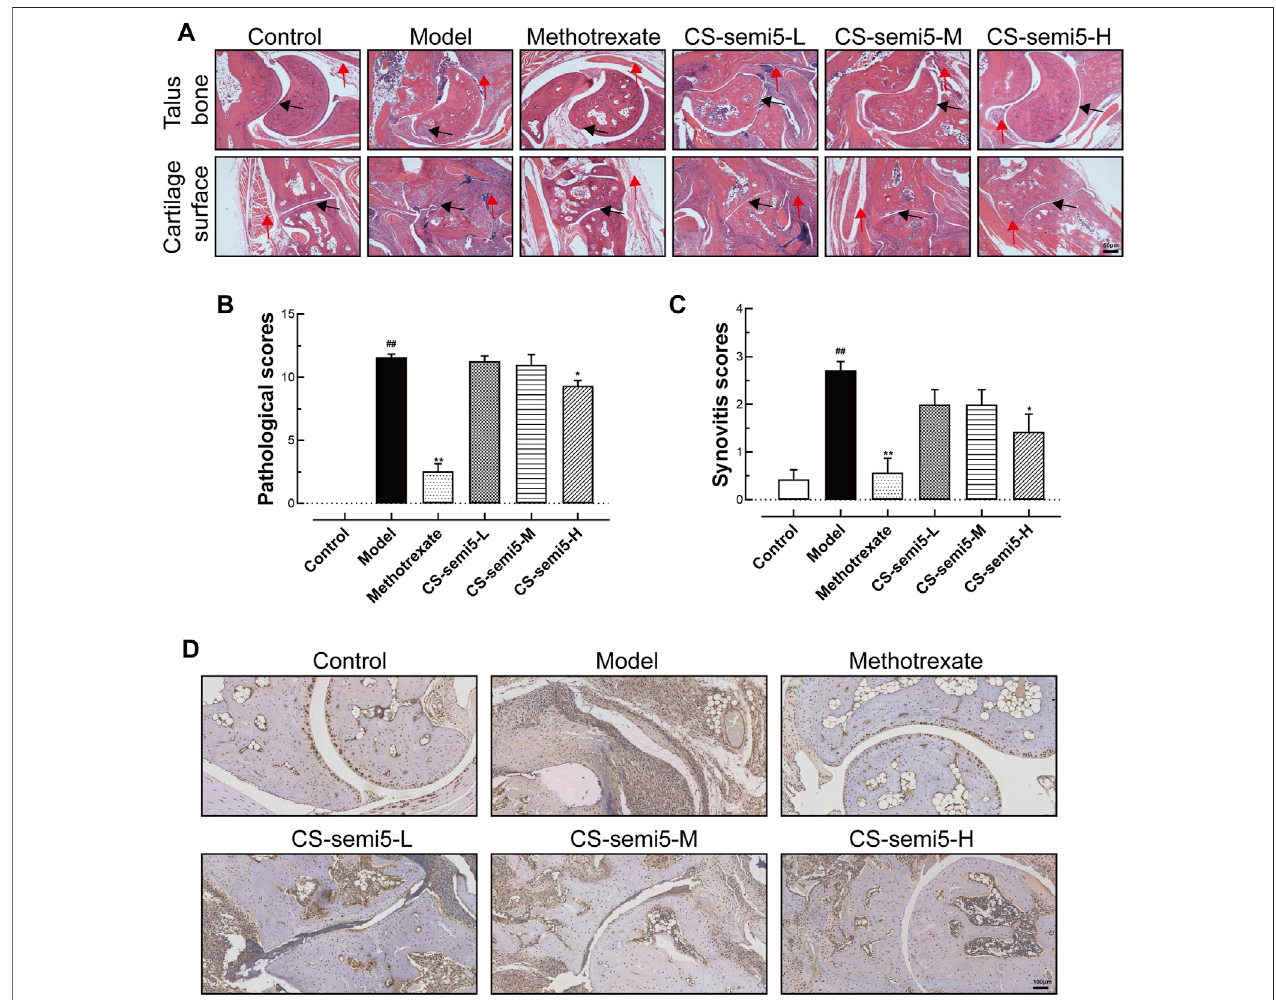
FIGURE 2 | CS-semi5 limits collagen-induced synovium in fl ammation and in fl ammatory in fi ltration in CIA mice. (A) Histologic images of talus bone and cartilage surface of ankle joints stained with H&E (40 × magni fi cation). Red arrows indicate synovial lining hyperplasia, in fl ammatory in fi ltration and pannus formation, and black arrows indicate invasive phenotype of the synovium. Bar indicates 50 μ m. (B) Pathological scores were calculated. (C) The degree of synovitis was semi-quanti fi ed basedonthesynoviallininglayers. (D) RepresentativehistologicsectionsofanklejointsfollowingimmunostainingwithCD68.CD68 + macrophagesstainedindyed brown. Scale bar represents 100 μ m n (cid:1) 7. ## p < 0.01 compared with Control group; * p < 0.05 and ** p < 0.01 compared with Model